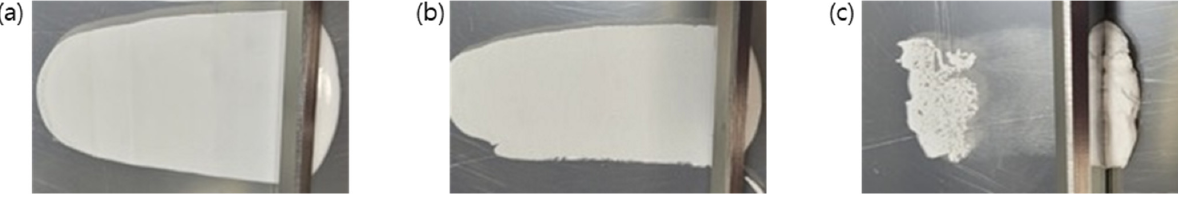
Figure 5. Digital photos of the coated ( a ) Al80, ( b ) Al85, and ( c ) Al90 composites on a release film.